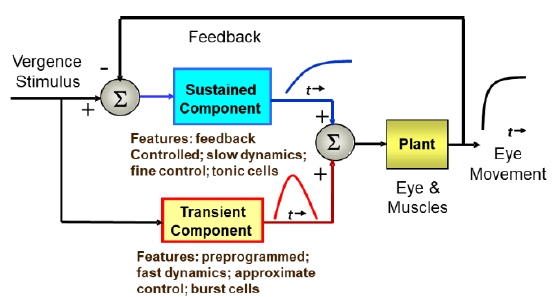
Figure 1: A schematic representation of the dual-mode control strategy showing the control pathways that include an initial, or fusion initiating control component and a slow, or fusion sustaining